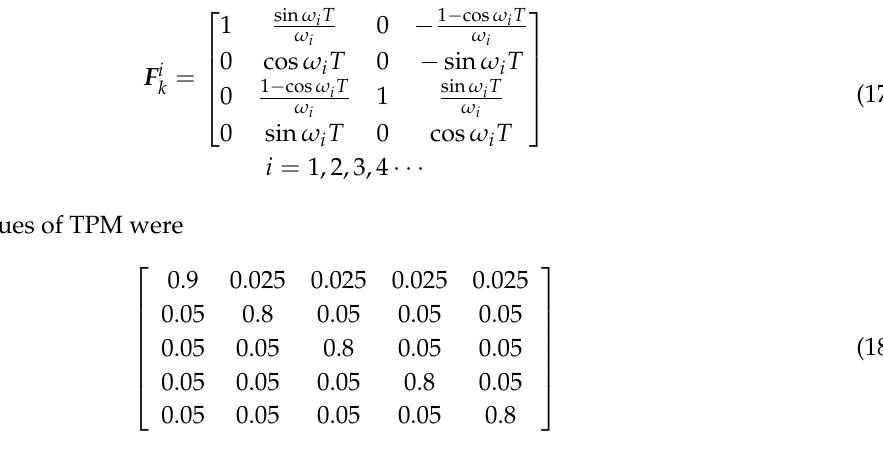
(cid:3036) . (cid:3038)